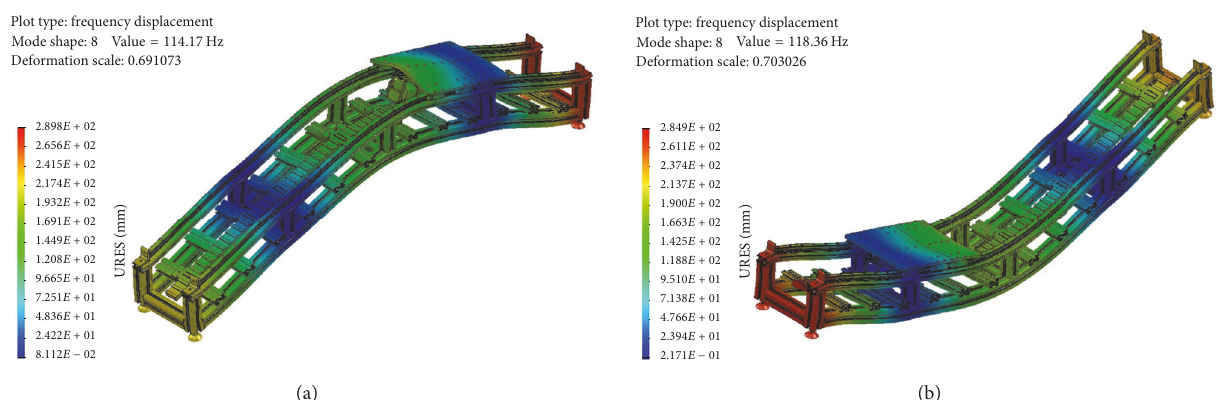
Figure 10: Modal shapes for mode 8, with vertical displacement in both ends: (a) at position P2 ( 𝑓 ≈ 114Hz, deformation scale ≈ 0.691); (b) for position P4 ( 𝑓 ≈ 118 Hz, deformation scale ≈ 0.703).